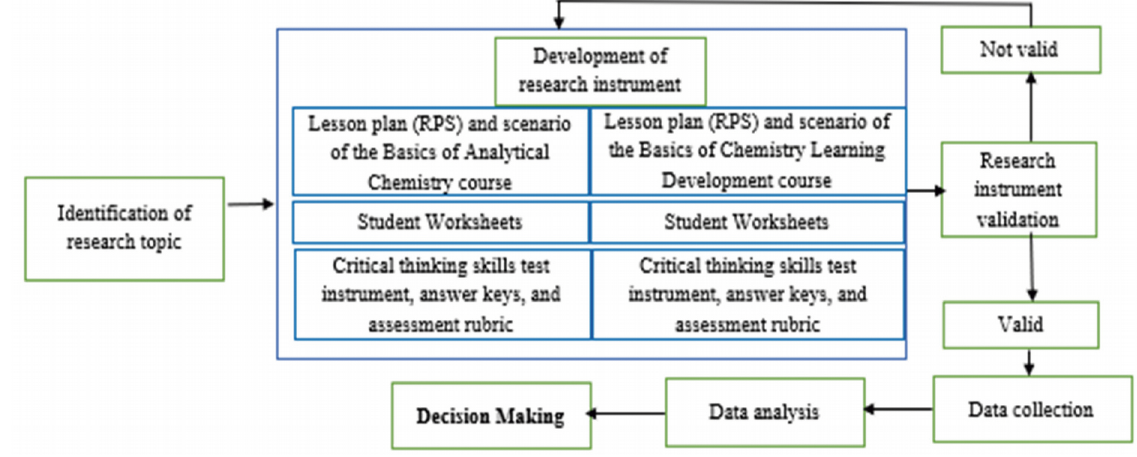
Figure 1. Research